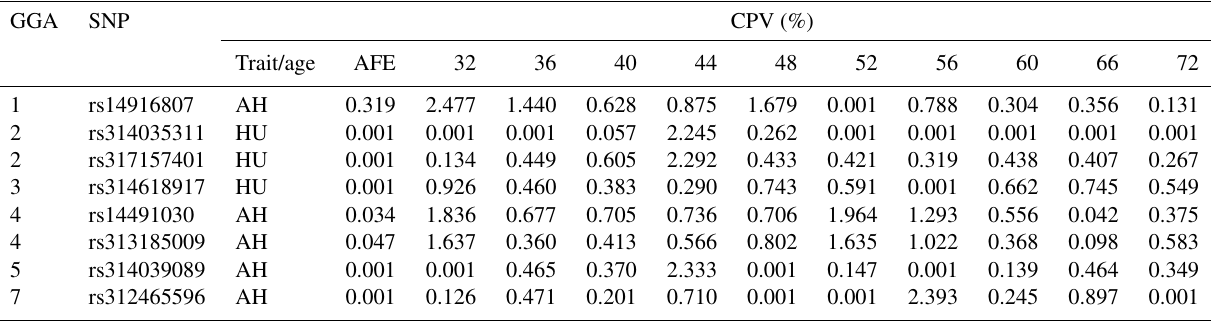
Table 6. Contributions to the phenotypic variance in albumen quality by eight mutations at different weeks. GGA